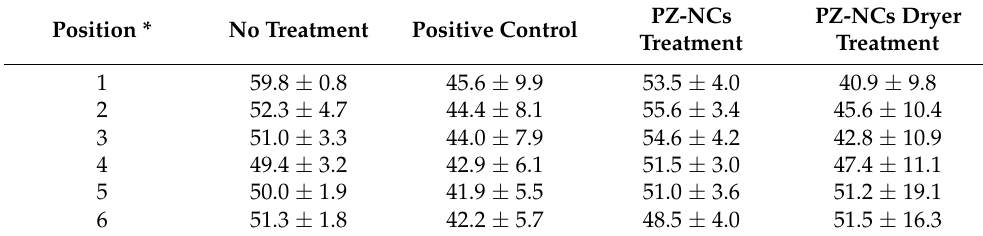
Table 2. Interfibrillar spacing (nm). Data are expressed as the mean ± SD ( n = 4). Position *